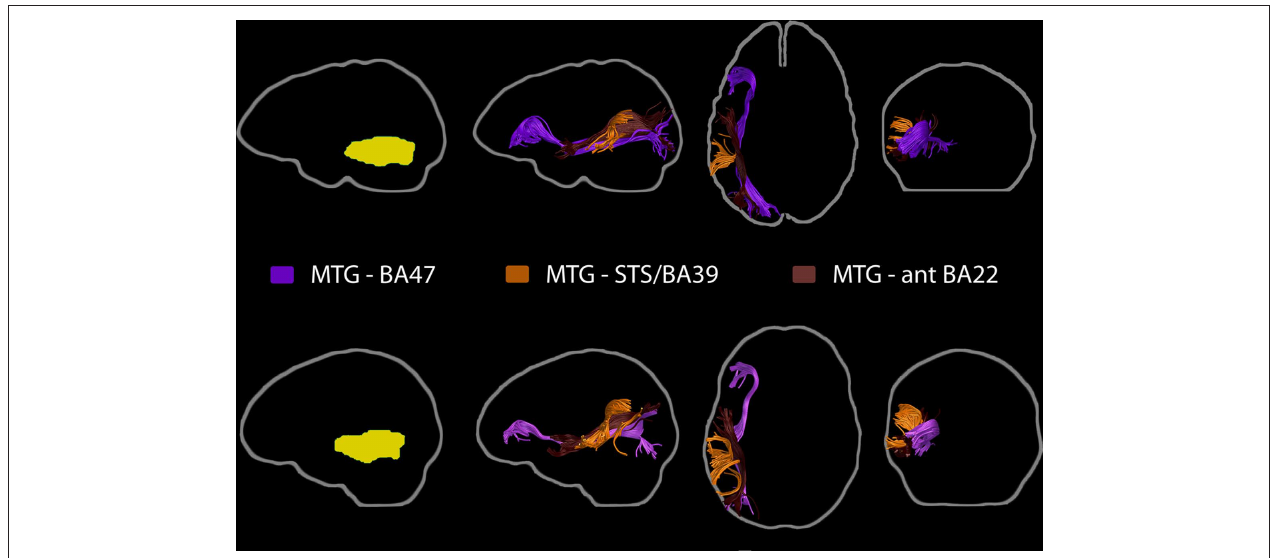
BA47 were identified as part of the IOFF. Those connecting MTG with STS/ BA39 were consistent with fibers of the indirect segment of the AF. The pathway likely to connect the MTG ROI with the anterior STG/BA22 ROI was identified as the MdLF.